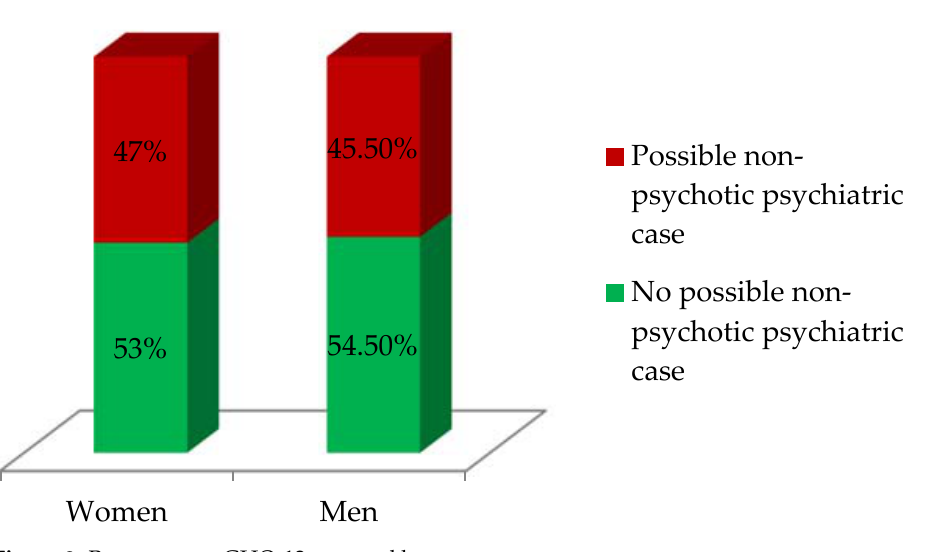
Figure 2. Responses to GHQ-12 grouped by sex.